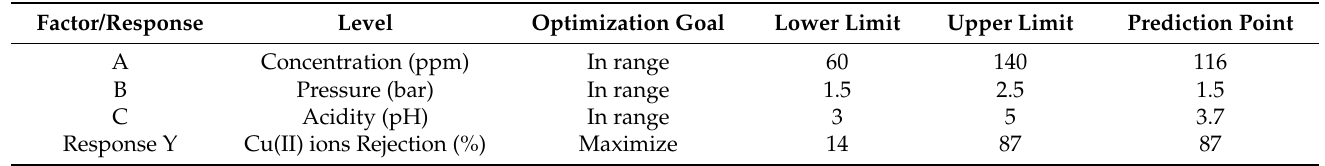
Table 5. Numerical optimization and model validation for JPU/GO 0.50 wt%.